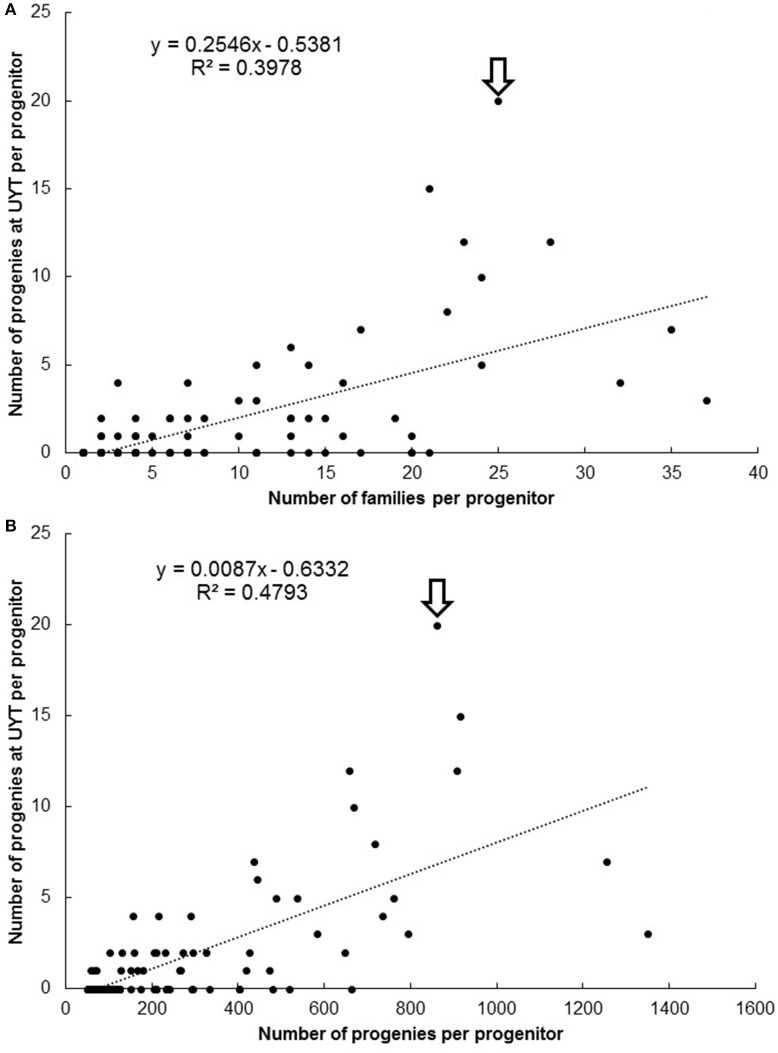
Number of families (A) and progenies (B) per progenitor against the number of clones derived from each progenitor reaching UYT (arrow identifies SM 1411-5).